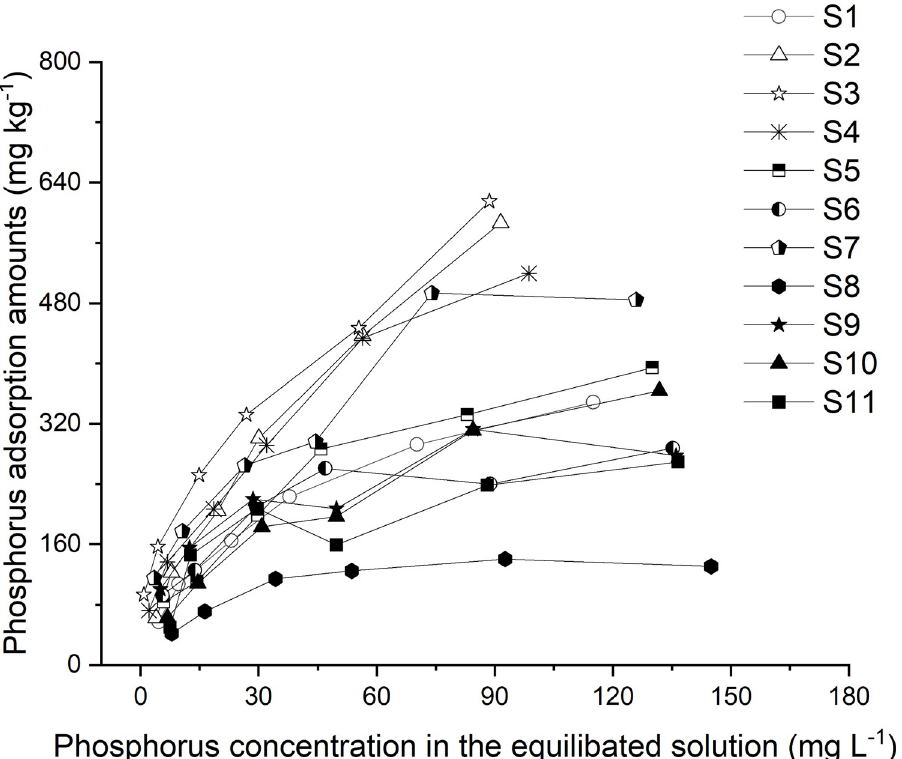
Fig 4. Phosphorus (P) adsorption isotherms in soil from different fields (n = 11) � . � Information of eleven soils see Table